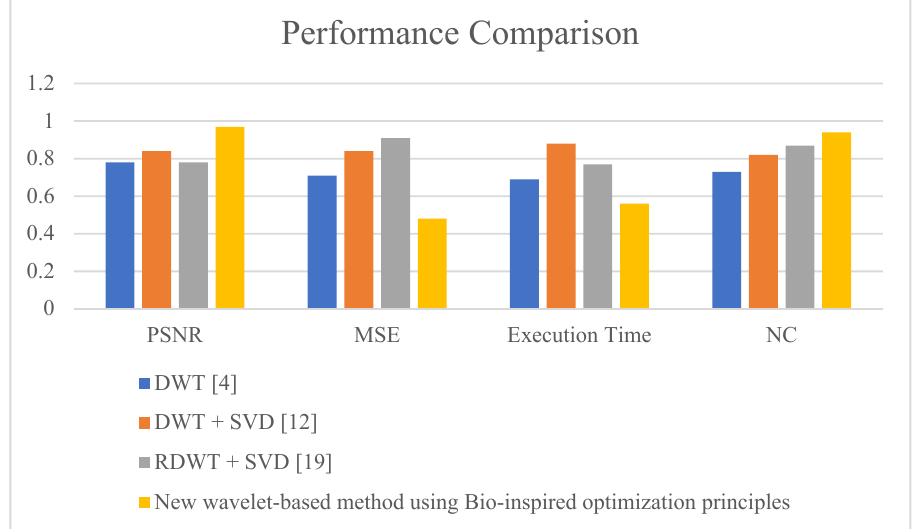
Figure 21. Overall performance comparison of the proposed method with existing methods.